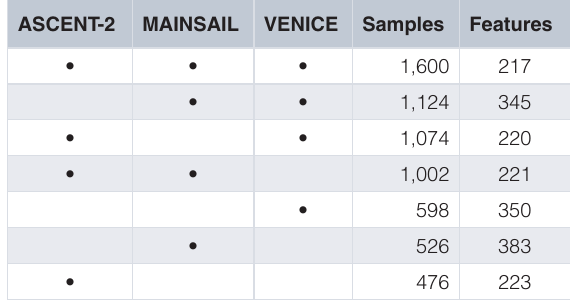
Table 1. Different sets of features that were constructed by considering the intersection between trials in the Prostate Cancer DREAM